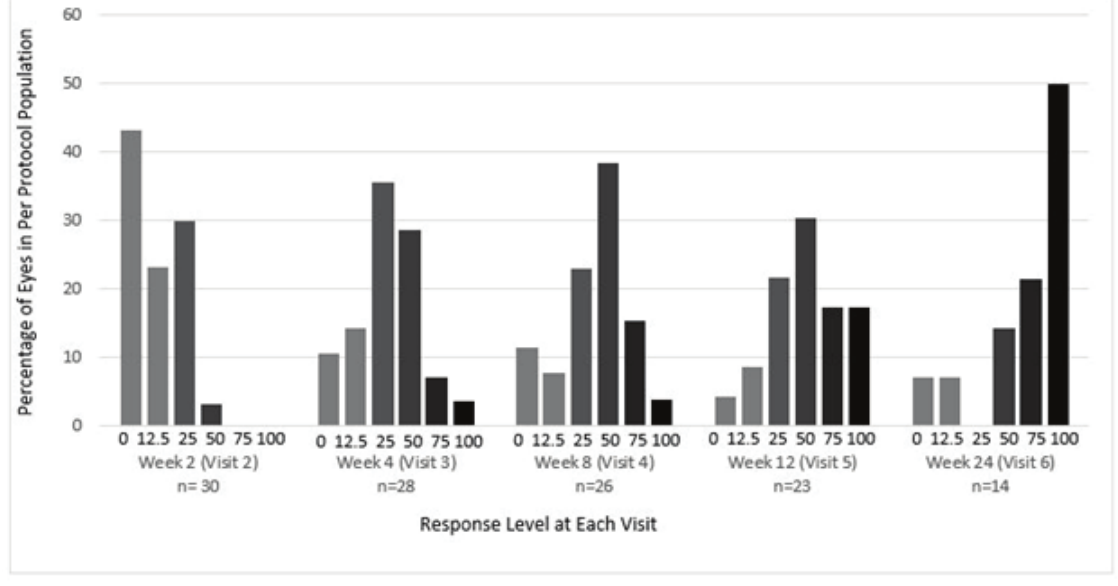
Figure 4. Percentage of PPP eyes with varying RL at each study visit after baseline.